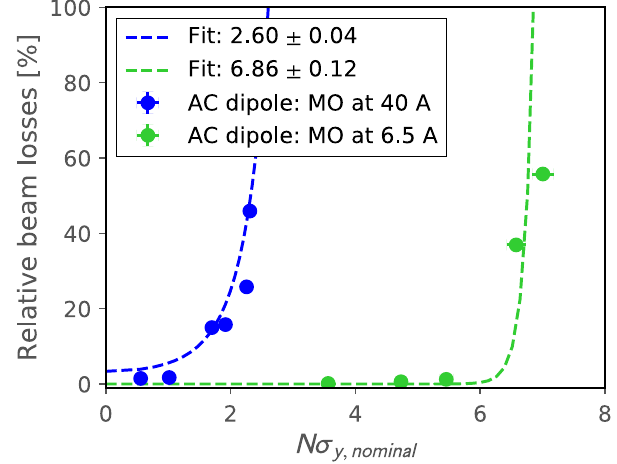
FIG. 14. Measured losses for ac dipole excitations with Landau octupoles powered at 40 A (blue) and 6.5 A (green).